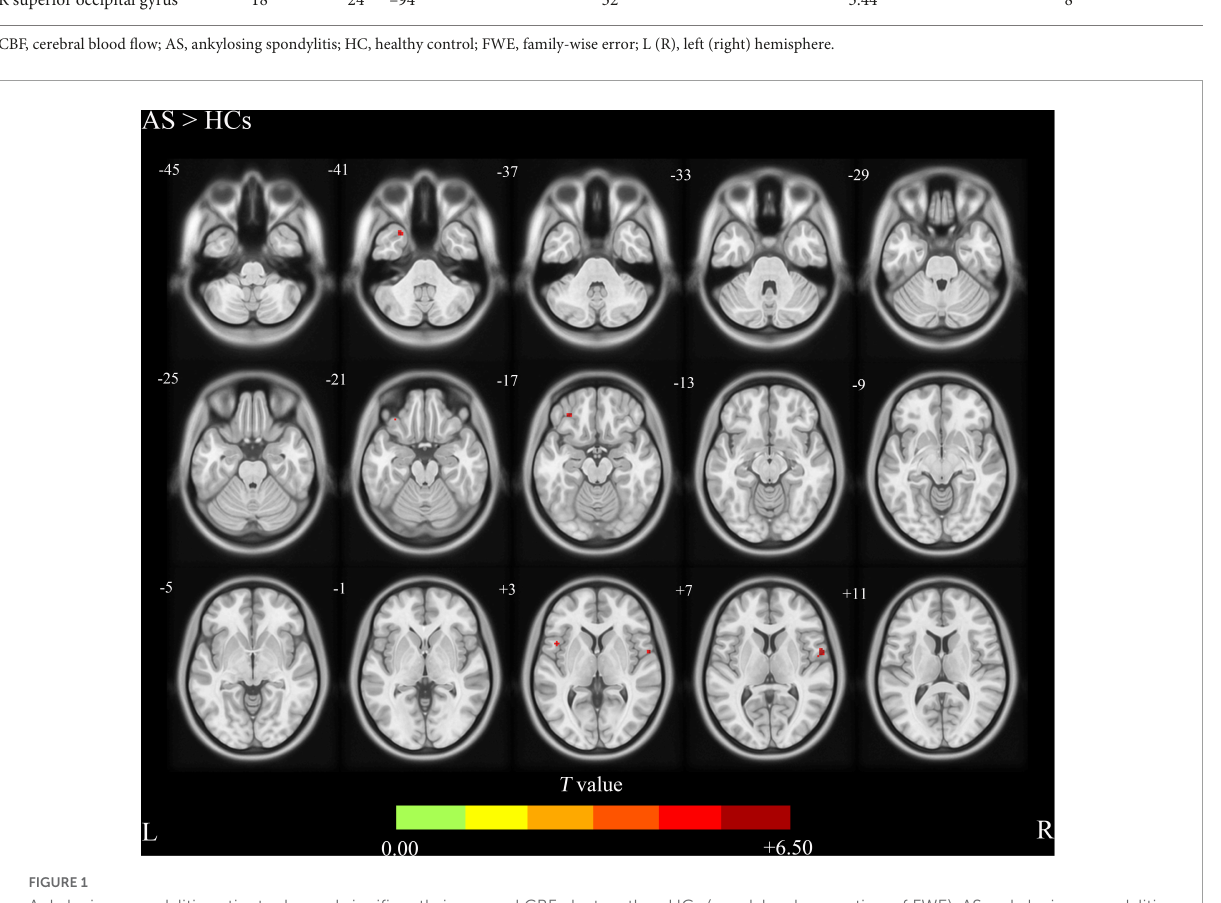
Temporal Pole, the left precuneus, the superior occipital gyrus, and the TBP, ESR, and